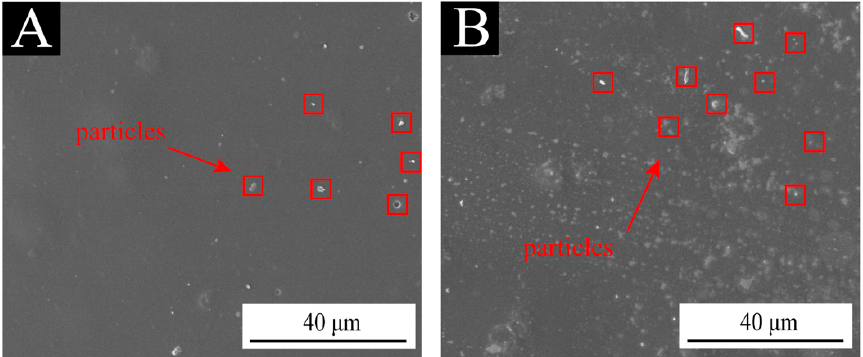
Figure 4. SEM of the coating prepared by coating process on three times of primer and two times of finish: ( A ) without microcapsules and ( B ) with microcapsules in the primer.